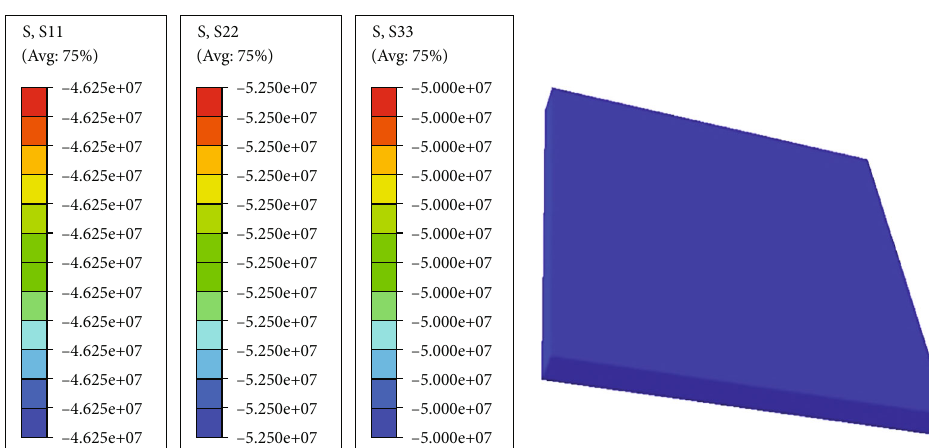
Figure 7: Stress nephograms in all directions (S11, S22, S33) after in situ